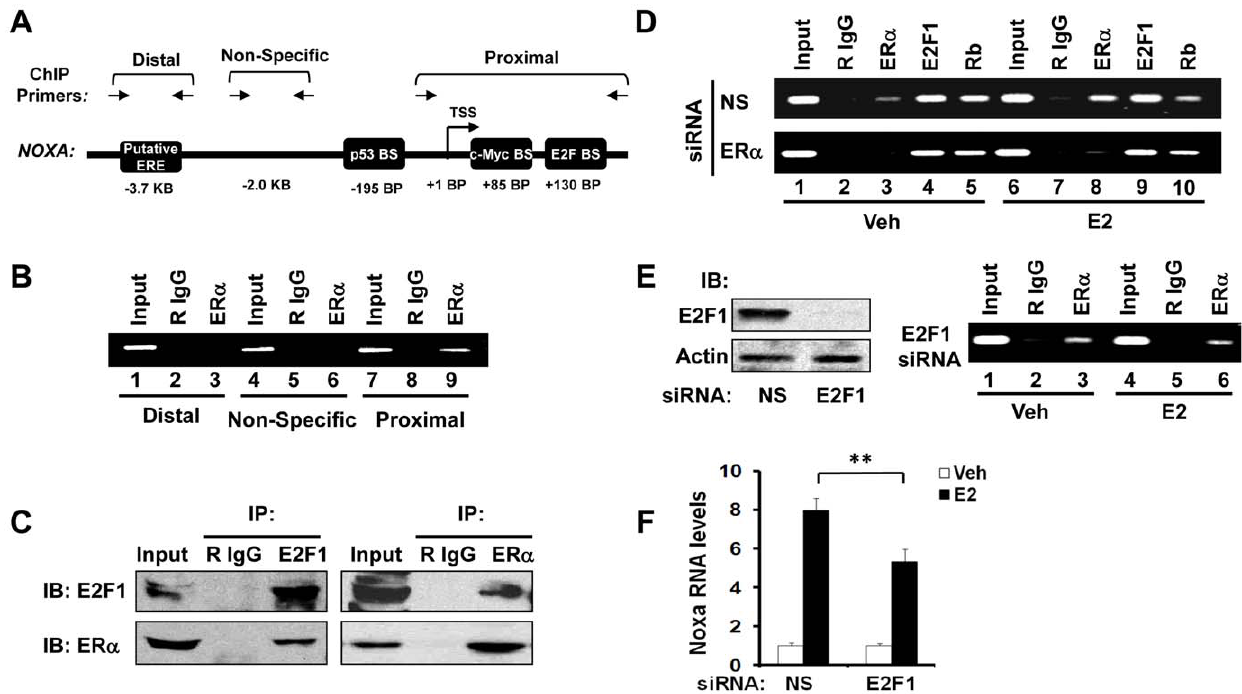
Figure 3. E2F1 mediates ER a -binding to the NOXA promoter in the presence of E2. ( A ) Schematic representation of the NOXA promoter. Horizontal arrows indicate the primers used for PCR in site-specific ChIP assays. Note that the figure is not drawn to scale. BS: binding site. TSS: transcription start site. ERE: estrogen response element. KB: distance in kilobases from the TSS. BP: distance in base pairs from the TSS. ( B ) ChIP assays were performed on MCF7 cell lysates to detect ER a binding to the NOXA promoter. Anti-ER a antibody or normal rabbit IgG (R IgG; control antibody) were used to immunoprecipitate ChIP DNA, and ChIP PCR was performed using primers that amplify a putative ERE site at 2 3.7 kb (lanes 1–3), a non- specific (NS) negative control site where no binding is expected to occur (lanes 4–6), and the proximal region of the NOXA promoter (lanes 7–9). PCR products were resolved on agarose gels. ( C ) Co-immunoprecipitation (co-IP) of protein complexes containing ER a and E2F1. Left panel: normal rabbit IgG (R IgG; antibody control) or anti-E2F1 antibody was used for immunoprecipitation (IP) and anti-E2F1 and anti-ER a antibodies were used for immunoblotting (IB). Right panel: R IgG or anti-ER a antibody was used for IP and anti-ER a and anti-EF21 antibodies were used for IB. ( D ) MCF7 cells were transfected with non-silencing control (NS) or ER a siRNA for 24 hr, followed by treatment with E2 (10 nM) or vehicle (veh) for 4 hr. The recruitment of ER a , E2F1, and RB to the proximal region of the NOXA promoter was analyzed by ChIP assays, as in B. ( E ) Left panel: MCF7 cells were transfected with non-silencing control (NS) siRNA or E2F1 siRNA for 48 hr, and E2F1 protein levels were monitored by western blotting. Right panel: MCF7 cells were transfected with E2F1 siRNA for 24 hr and then treated with vehicle (veh) or E2 (10 nM) for 4 hr. Recruitment of ER a to the proximal region of the NOXA promoter was analyzed by ChIP assays, as in B. ( F ) MCF7 cells were transfected with non-silencing control (NS) siRNA or E2F1 siRNA for 24 hr and then treated with vehicle (veh) or E2 (10 nM) for 8 hr. Noxa mRNA expression was assayed by qPCR. Graphical data points in F are means 6 S.D. of three independent experiments (** P ,